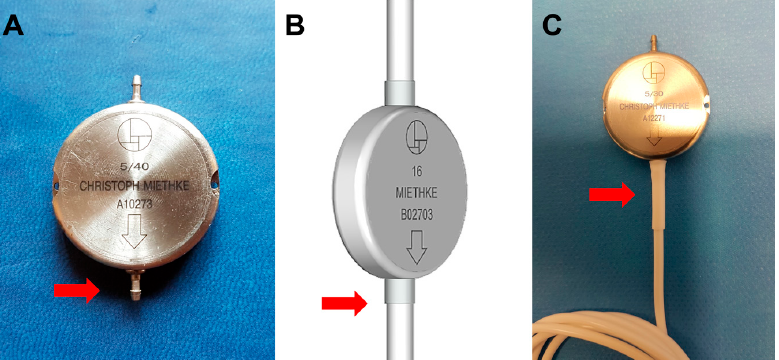
Figure 6. Schematic diagrams and real images of the first ( A ), second ( B ), and third ( C ) generation of the Miethke ® Dual-Switch Valve. Among other aspects, the most important design improvement was the mechanical robustness of the catheter-connector linkage (arrows).